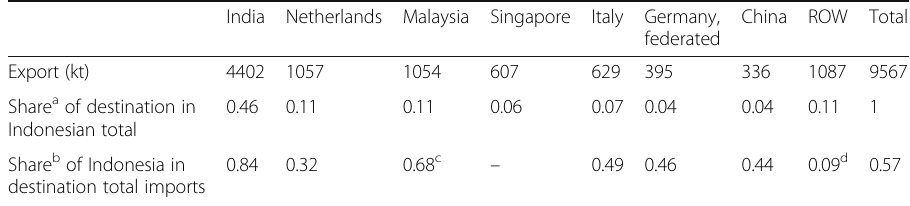
Table 2 Exports of Indonesian palm oil to destination markets,